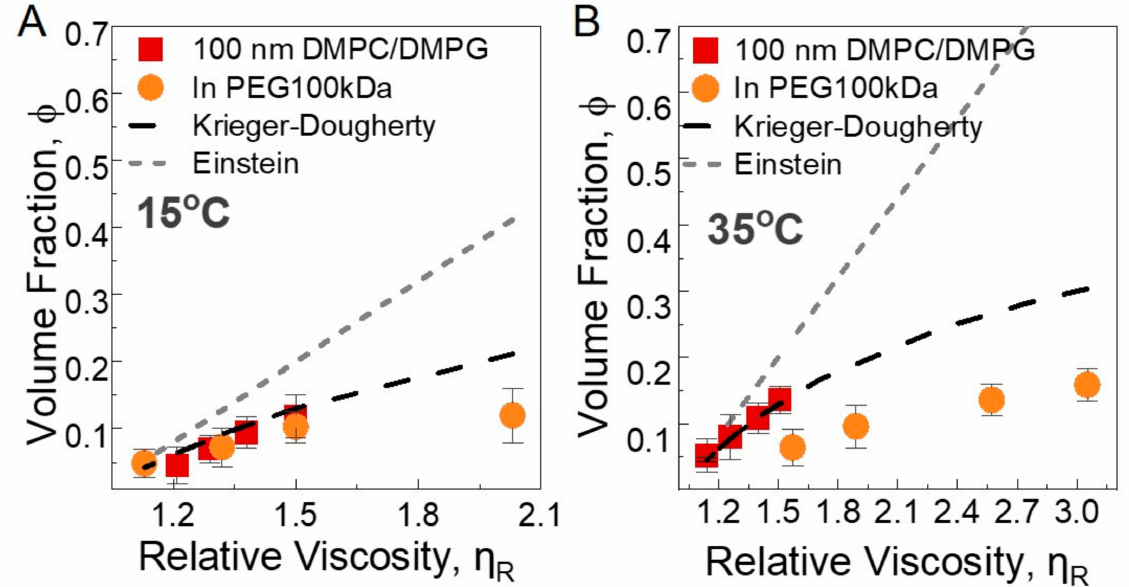
Figure 5. Volume fractions versus relative viscosity of the neat 100 nm liposome solutions and liposomes in 1.7 wt% PEG (100 kDa) solutions at four lipid concentrations (2.5 wt%, 2 wt%, 1.5 wt%, and 1 wt%). The curves show the predictions of Einstein and Krieger–Dougherty viscosity models at ( A ) 35 ◦ C and ( B ) 15 ◦ C. The data are averaged over three separate measurements, and the error bars represent one standard